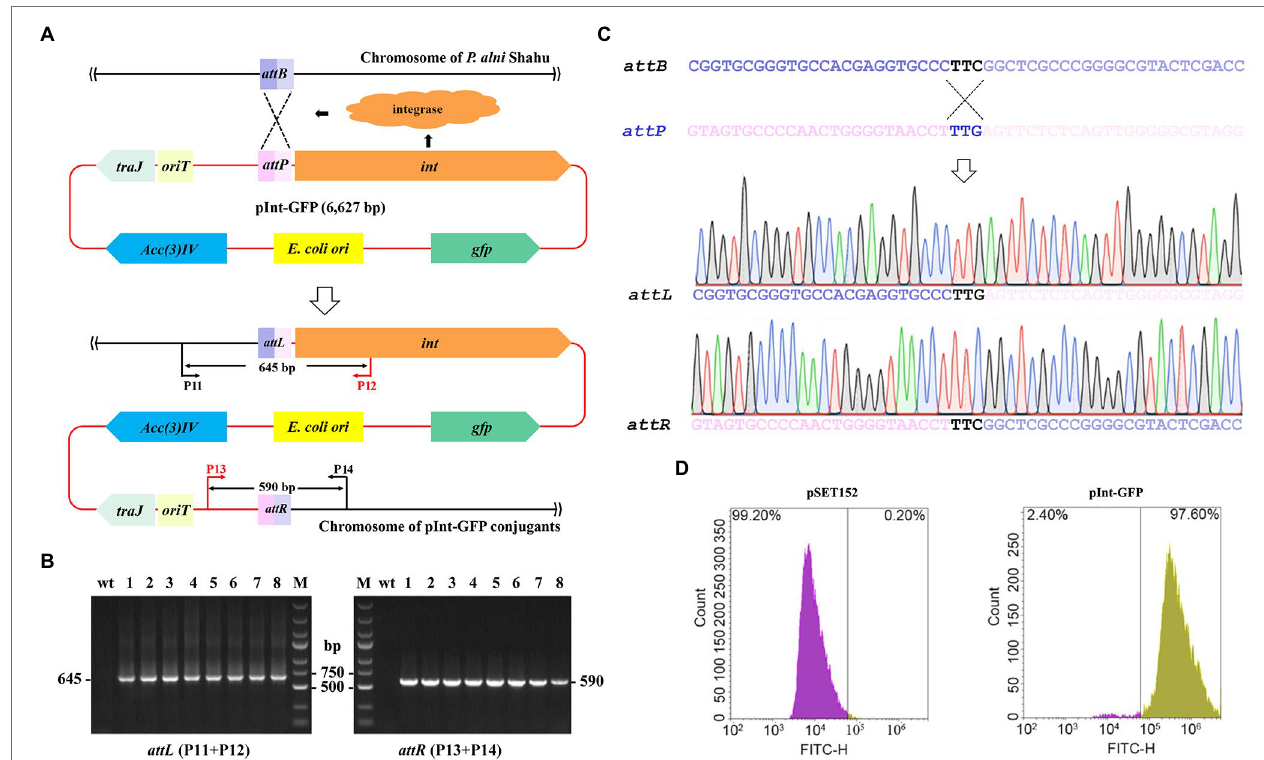
FIGURE 2 | Chromosomal integration of the exogenous gfp gene using the Φ C31 att/int system. (A) Schematic showing integration of the entire pInt-green fluorescent protein (GFP) plasmid into P. anli Shahu chromosome. (B) Colony PCR analyses of eight randomly taken exconjugants, and the wild-type strain (wt) as a reference, using primer sets of P11 + P12 and P13 + P14 as shown in (A) . Predicted sizes of PCR products encompassing the created hybrid attL and attR sites after integration are indicated. M, DNA size marker. (C) Representative chromatographs of Sanger sequencing results of the attL and attR sites. Original sequences of attB in P. anli Shahu chromosome and attP in pInt-GFP plasmid, respectively, are shown. (D) Signal of GFP was detected in the pInt-GFP exconjugant whereas not in the pSET152 exconjugant by flow